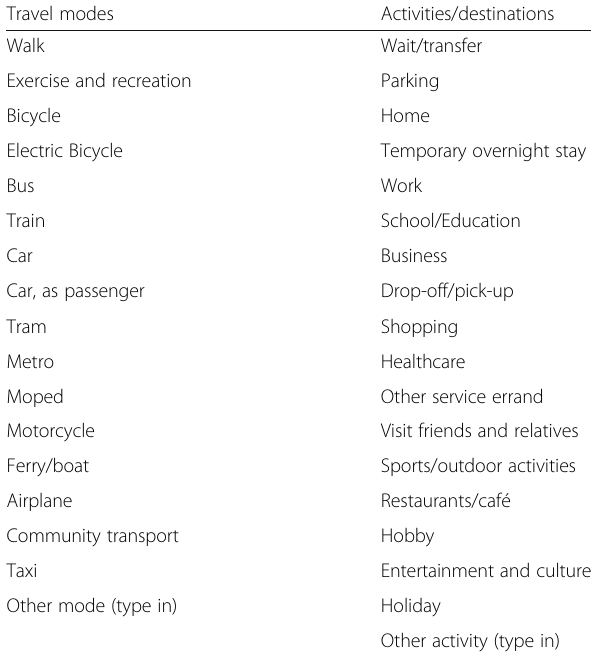
Table 3 Logged travel modes and default categories of activities in